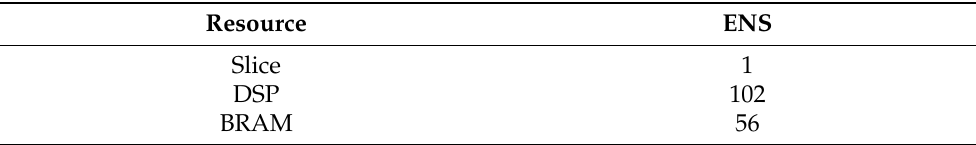
Table 1. Equivalent slice number of FPGA hardware resources.